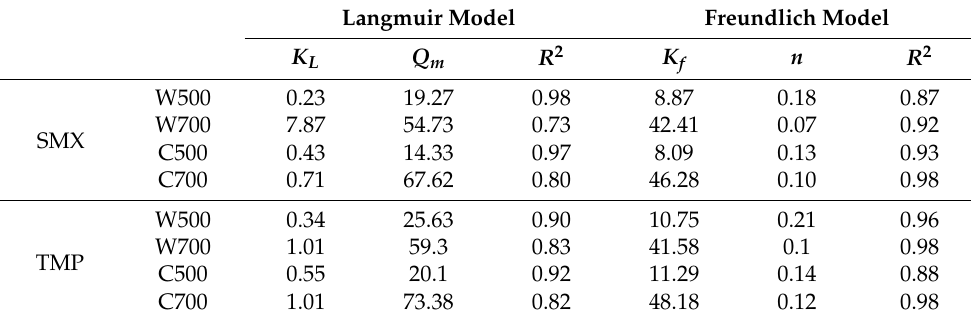
Figure 4. Adsorption for SMX ( A , B )/TMP ( C , D ) on biochars. Table 4. Adsorption models of SMX/TMP on biochars.